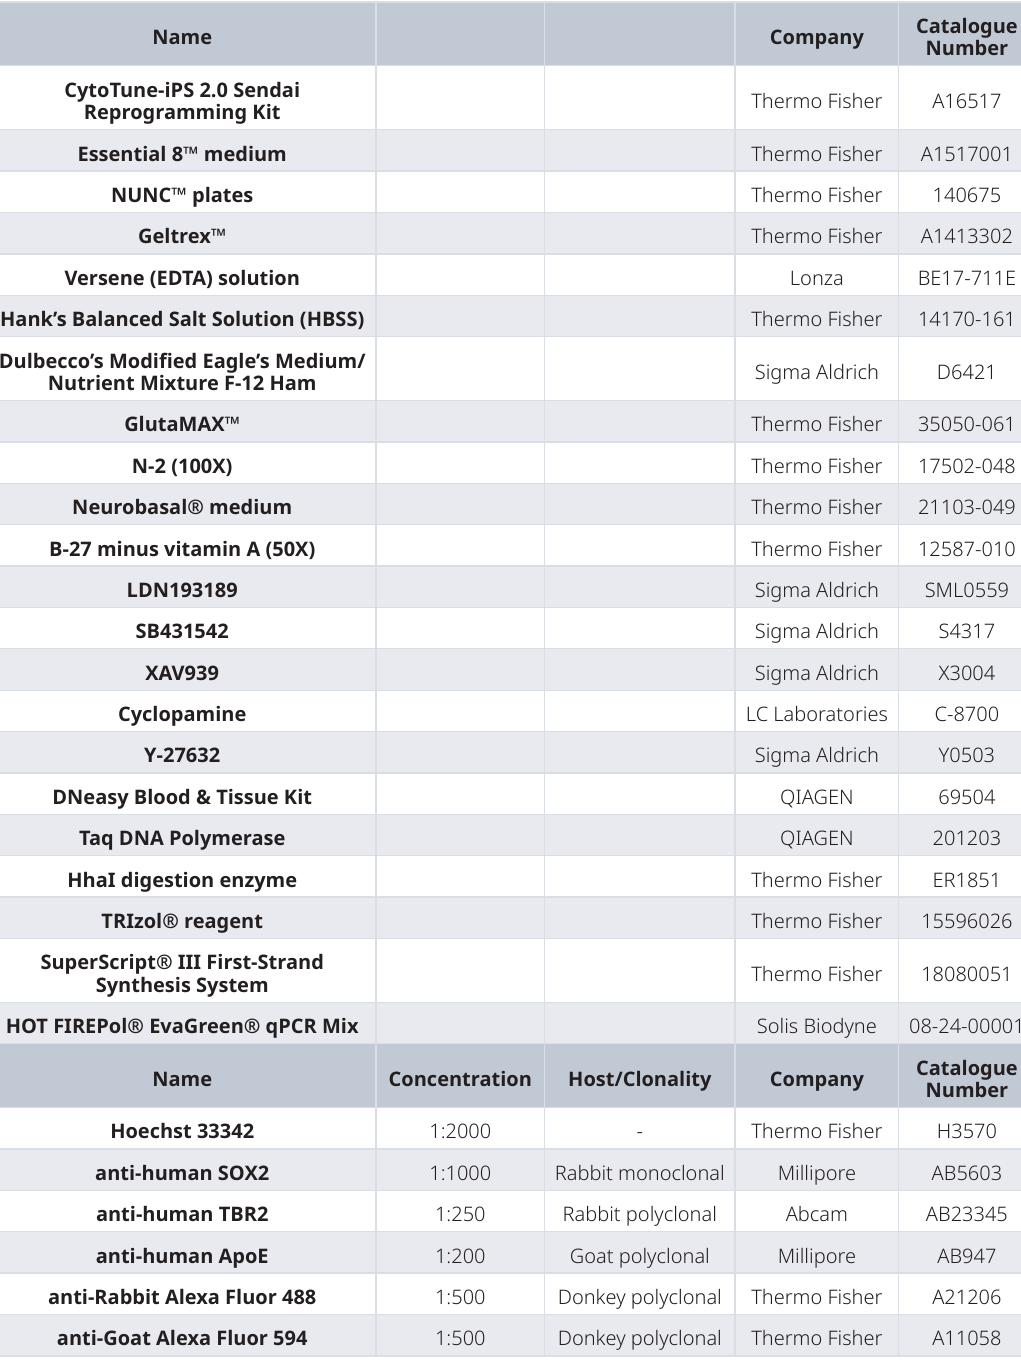
Table 1. List of materials used in this